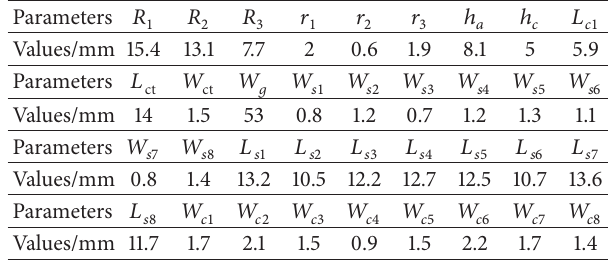
Table 1: Optimized parameters of the proposed